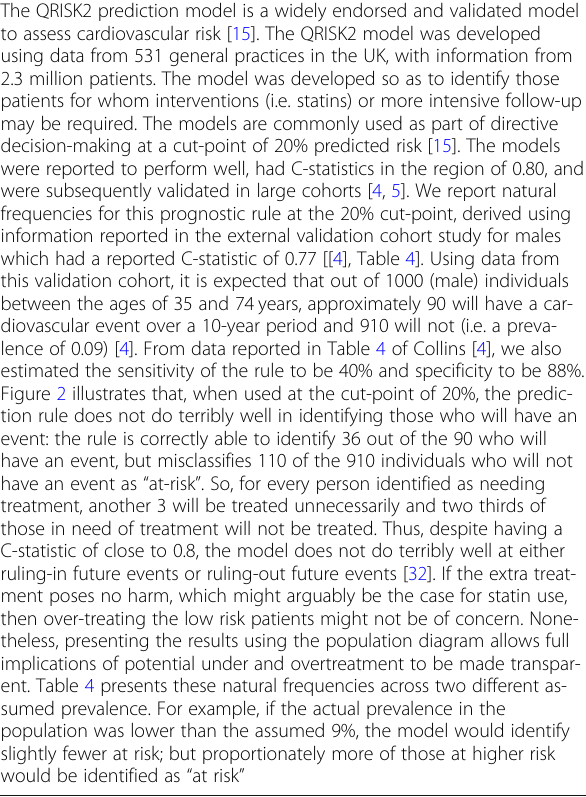
Table 3 Case Study 2 the QRISK2 prediction